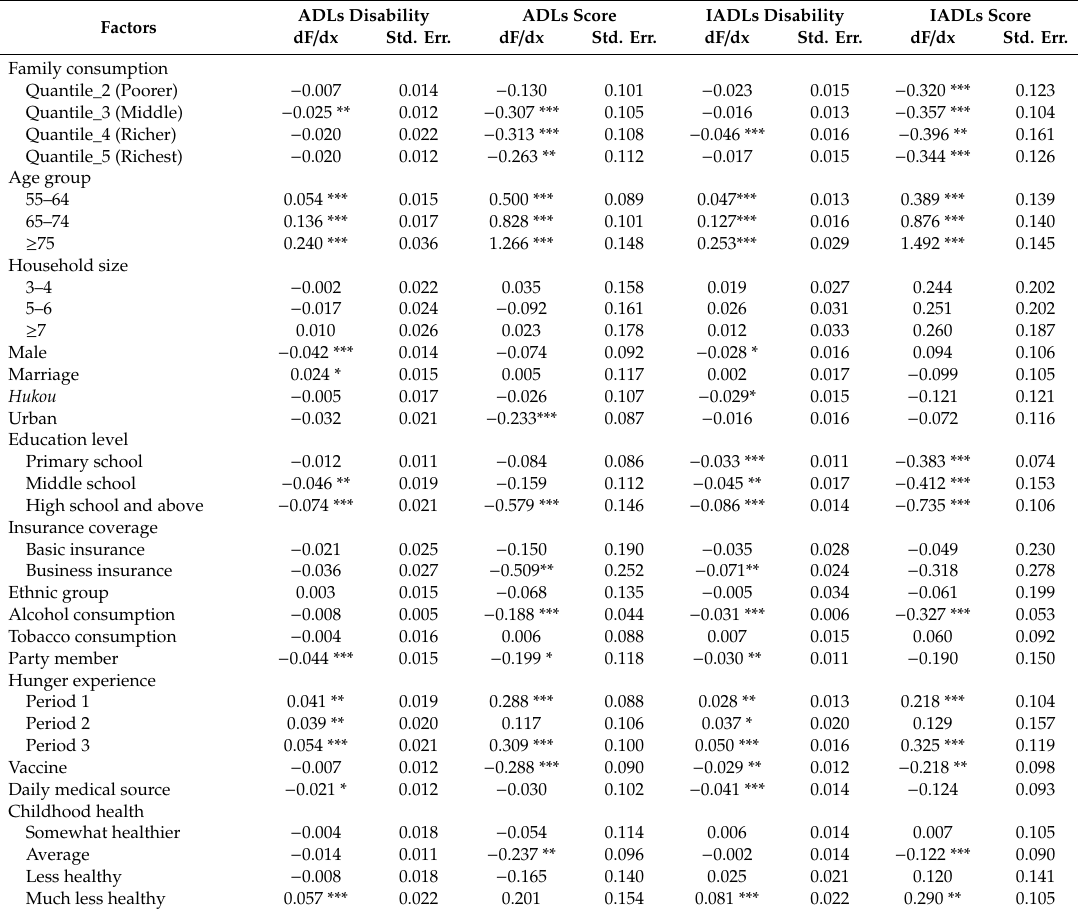
Table 3. Factors influencing long-term care need among older adults with chronic disease. ADLs Disability ADLs Score IADLs Disability IADLs Score Factors dF / dx Std. Err. dF / dx Std. Err. dF / dx Std. Err. dF / dx Std.